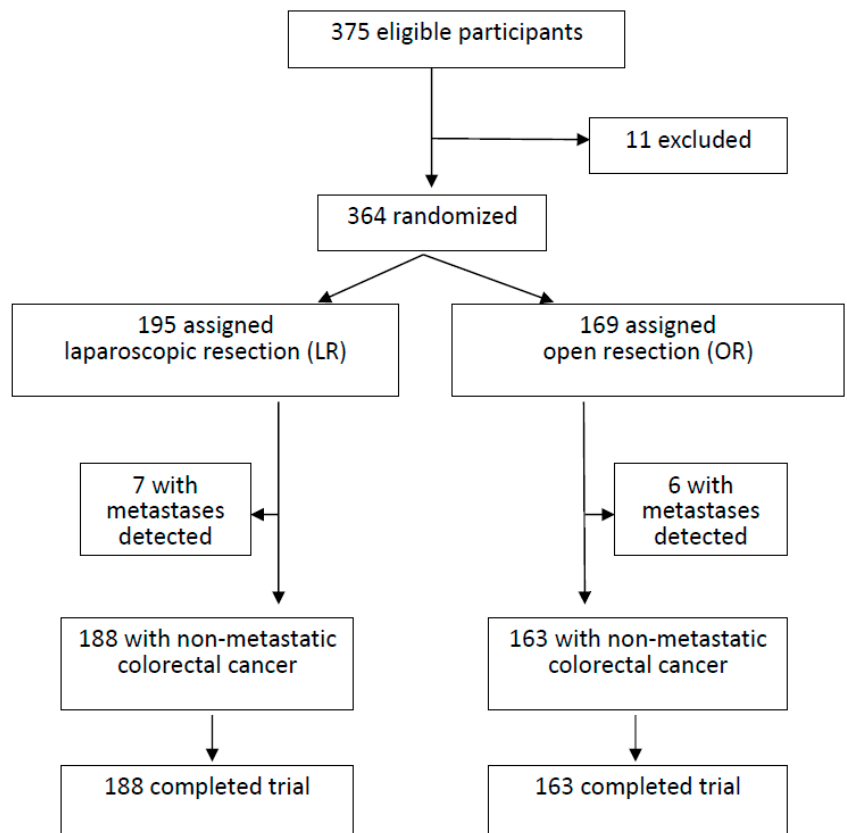
Figure 1. The flowchart of the study design.